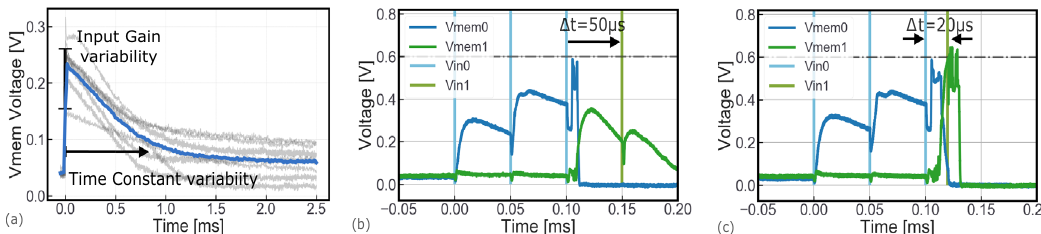
Fig. 5 Variability in analog neuromorphic circuits. a Experimental measurements of the response of nine randomly selected individual neurons to the same input spike. The response varies across the population impacting both the input gain and the time constant. b Experimental measurements of the impact of the neuron to neuron variability affecting the direction-sensitive CD. Due to the neuron-to-neuron variability, the two output neurons of the direction-sensitive CD respond differently to the input stimuli. Neuron 0 presents a lower input gain than neuron 1, thus requiring three input pulses (instead of 1) to produce an output spike. Neuron 1 reaches the threshold with two input events, as expected. If input 1 arrives Δ t = 50 μ s after neuron 0 has been excited, the CD remains silent because Δ t is larger than neuron 1's time constant (about 22 μ s). c Decreasing the Δ t = 20 μ s, makes input 1's spike to arrive when neuron 1's excitation is still high, resulting in the coincidence detection of the two input